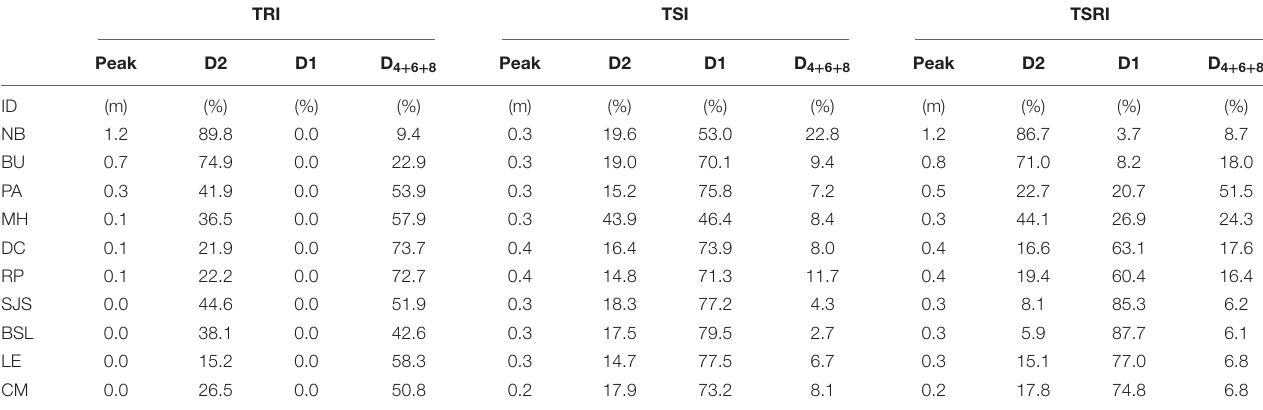
TABLE 4 | Relative contributions (%) of the D2, D1, and high-frequency (D4+D6+D8) bands to the total variance of TRI, TSI, and TSRI at 10 tidal gauges. TRI TSI TSRI Peak D2